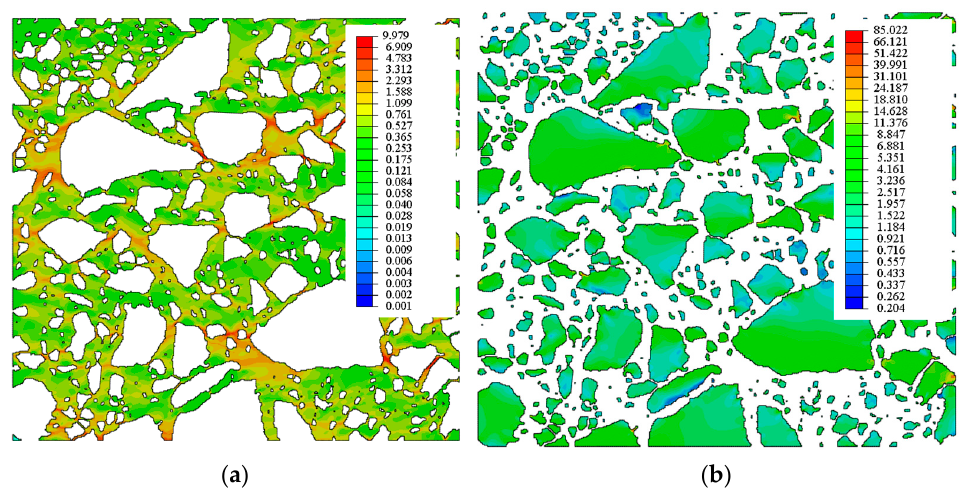
( b ) Figure 12. Contour graphs of principal strains: ( a ) maximum and ( b ) minimal in the mortar. The contour graphs of the equivalent Mises stresses in Figure 13 show local stress